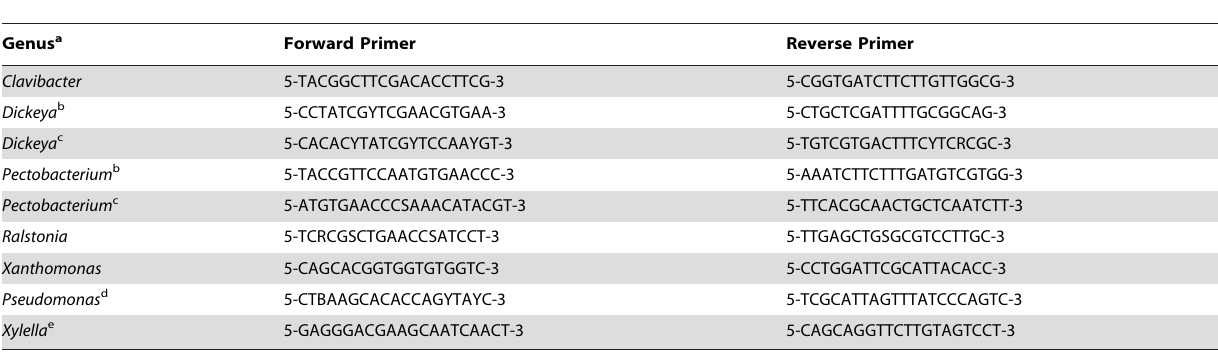
Table 3. RIF primers developed in this